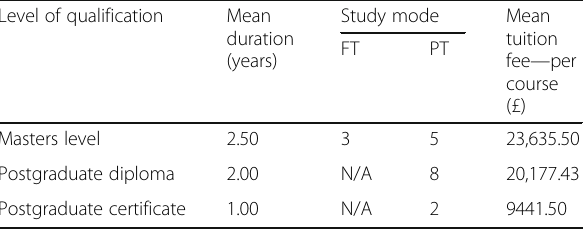
Table 3 Summary of findings from analysis of academic